Question: Write a single sentence explaining what this figure depicts.
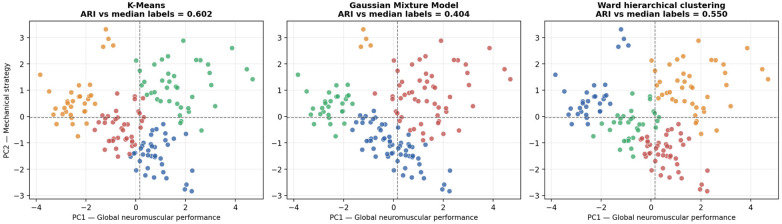
Answer: Comparison of the median-based labeling against three alternative unsupervised clustering strategies (K-means, Gaussian mixture model, ward hierarchical clustering) in the PC1–PC2 space. Adjusted Rand Index (ARI) values of 0.40–0.60 indicate moderate-to-substantial agreement, supporting the robustness of the median-based categorization.